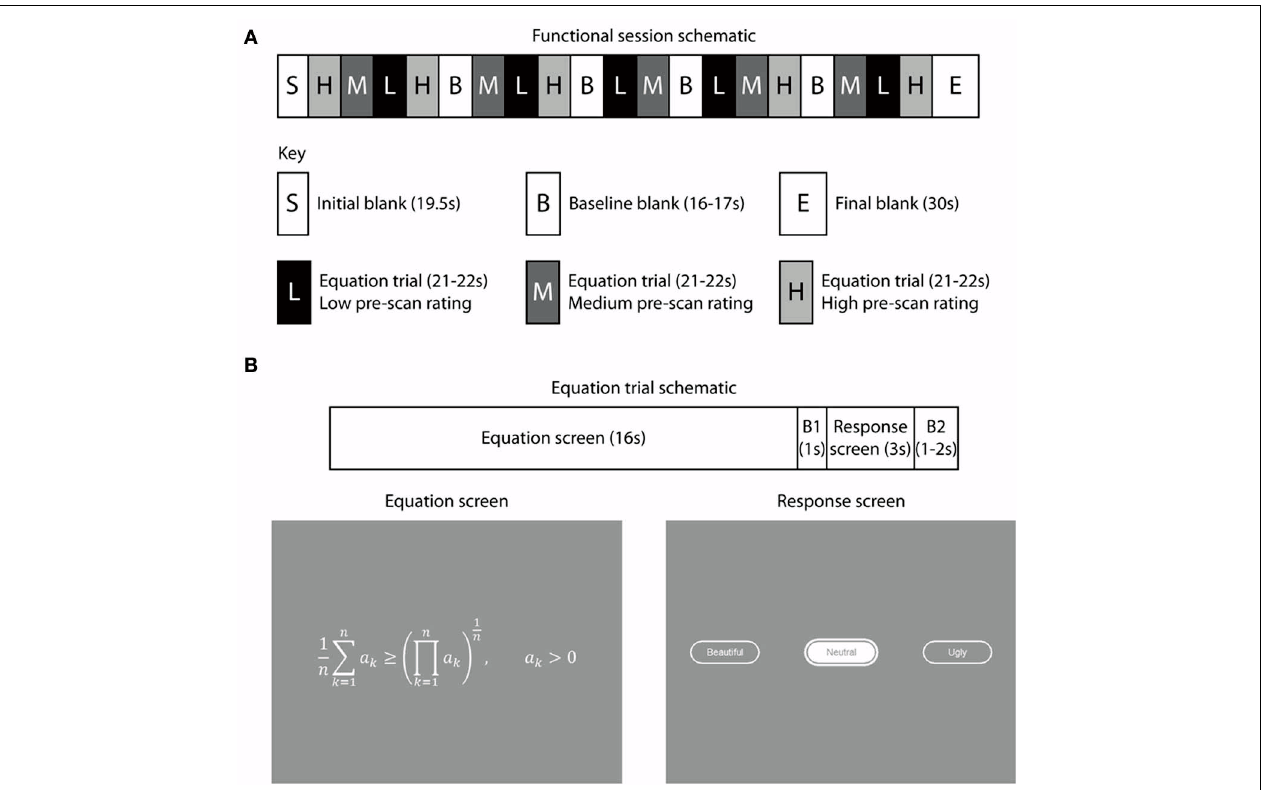
FIGURE 1 | Experimental paradigm and stimulus presentation. There were four functional scanning sessions, with a break between sessions. (A) 15 equations were displayed during each session, with each of the 60 equations appearing only once over the four sessions. The pre-scan beauty ratings were used to sequence the equations for each subject so that 5 low-rated (L), 5 medium-rated (M), and 5 highly-rated equations (H) appeared in each session and their sequence within a session organized so that a low-rated equation was never followed by another low-rated equation (similarly for medium and highly-rated equations). During each session four blank periods, each varying in duration from 16 to 17s, were inserted to collect baseline signal. Each session commenced with a 19.5s